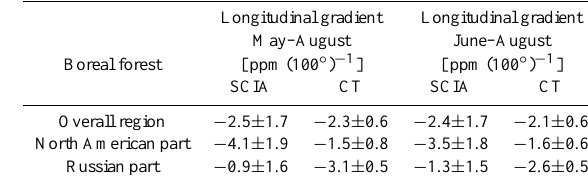
Table 2. West-to-east longitudinal gradients of 2003–2008 XCO 2 during the growing season (May–August) for the regions of Fig. 6. Also shown are the corresponding gradients for the shorter time pe- riod June–August minimising uncertainties due to potential regional timing errors in the onset of the forest uptake in the CASA